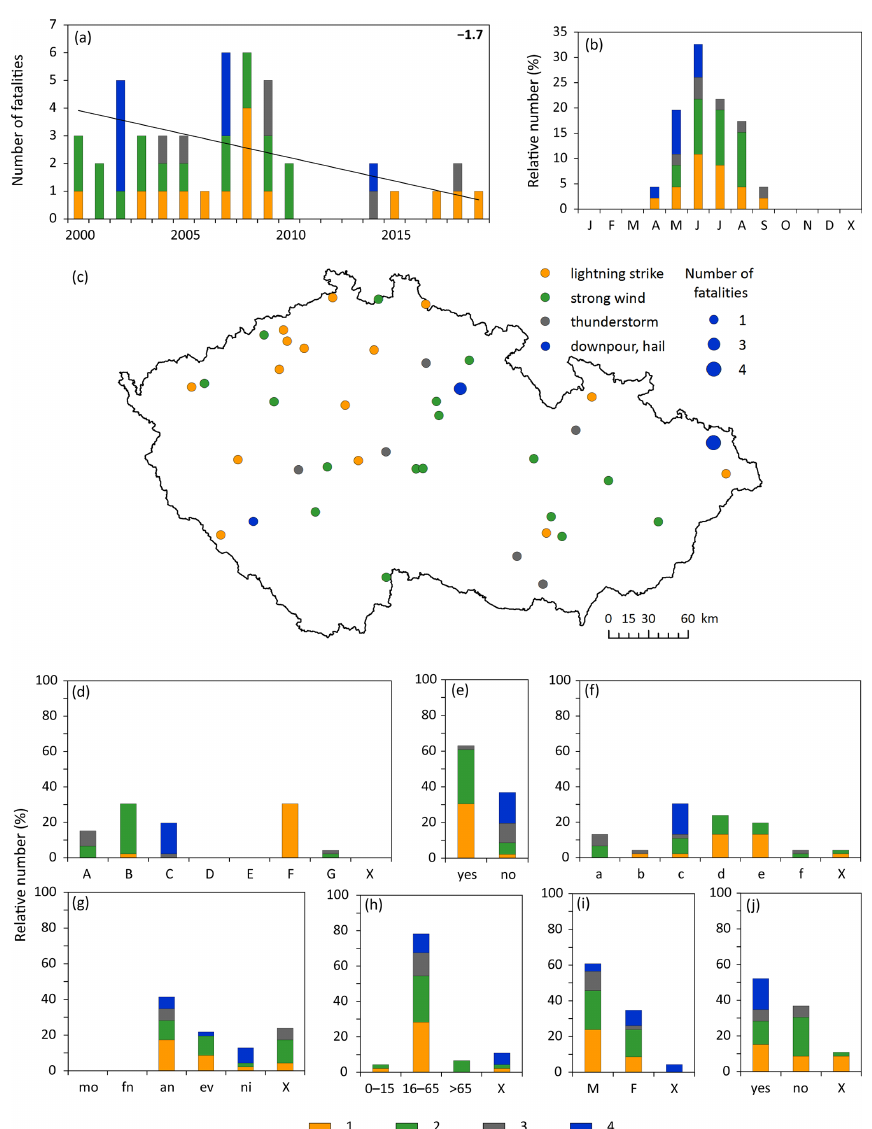
Figure 3. Characteristics of convective-storm-related fatalities (1 – lightning strike; 2 – strong wind; 3 – during a thunderstorm; 4 – downpour, hail) in the Czech Republic during the 2000–2019 period: (a) fluctuation with linear trend (top right, fatalities/10 years), (b) annual variation, (c) spatial distribution, (d) cause of death, (e) type of fatality, (f) place of death, (g) part of the day, (h) age, (i) sex, (j) behaviour. For explanation of symbols and abbreviations see Fig.